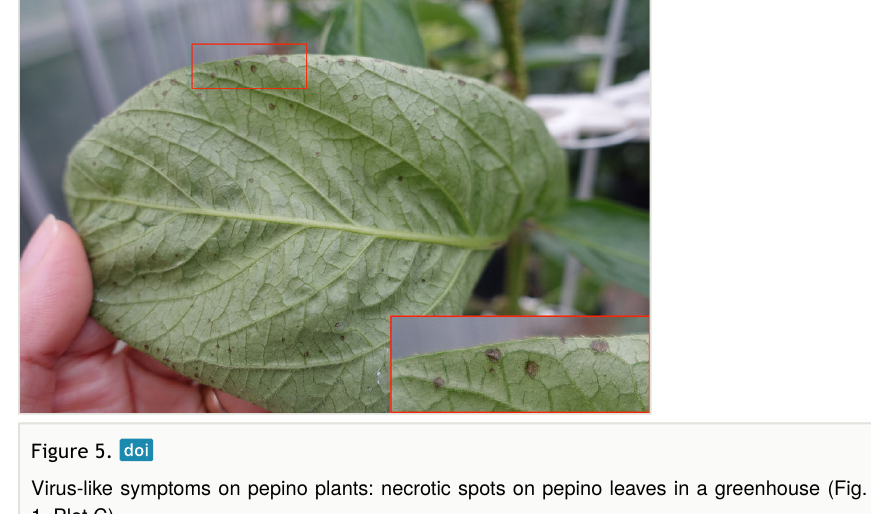
Figure 5. Virus-like symptoms on pepino plants: necrotic spots on pepino leaves in a greenhouse (Fig. 1, Plot